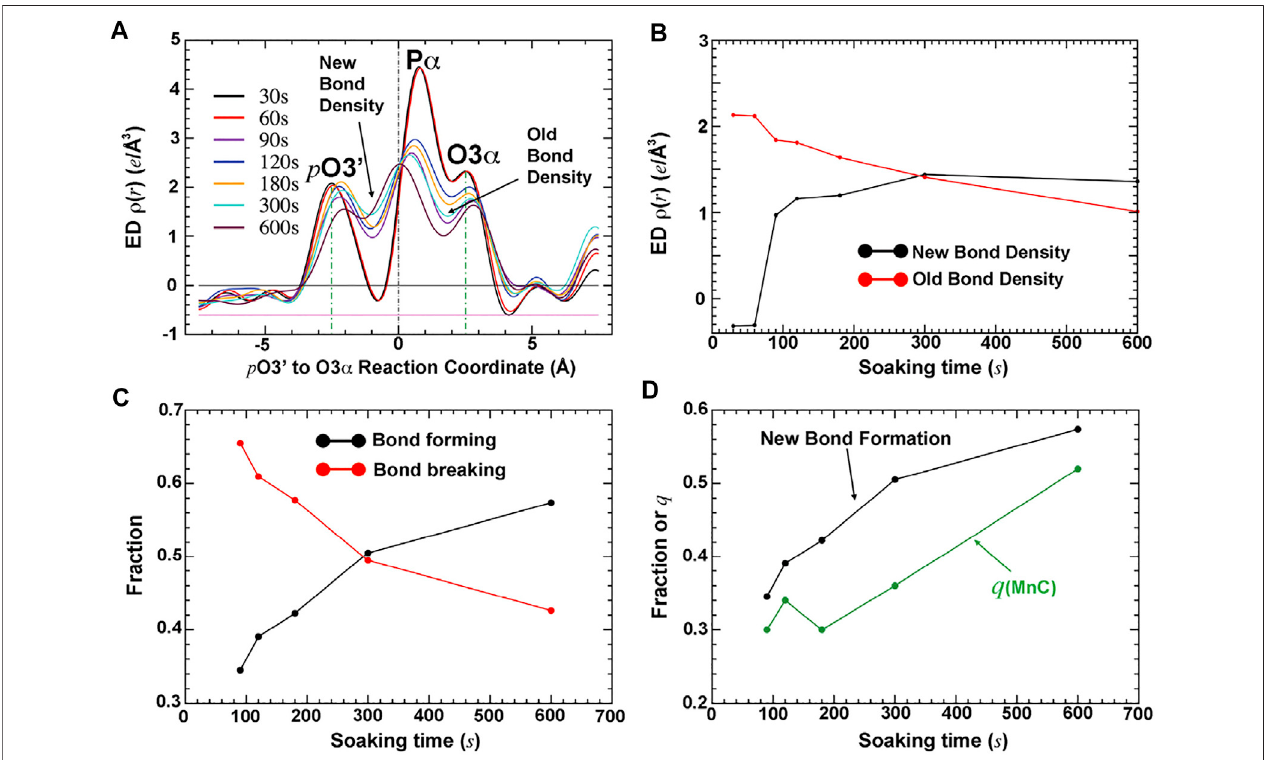
FIGURE 3 | Quantitative analysis of time-dependent electron density for bond formation, bond breaking, and occupancy of the third metal ion MnC (adapted from Wang and Smithline, 2019). (A) Plots of the σ A -weighted F o -F c electron density along the reaction coordinate from pt O 3 ′ to P α to O3 α . (B) Electron density at the positions de fi ning bond formation and bond breaking. (C) Fractions of bond formation and bond breaking. (D) Comparison of new bond formation relative to the occupancy of bound MnC helps to establish the relative order of the fi rst bond formation, followed by binding of MnC.